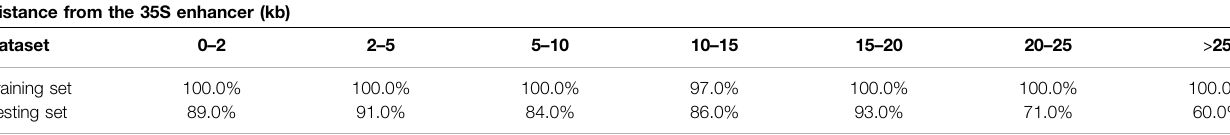
TABLE 6 | Predictive accuracy of TIMgo for different distance groups. Distance from the 35S enhancer